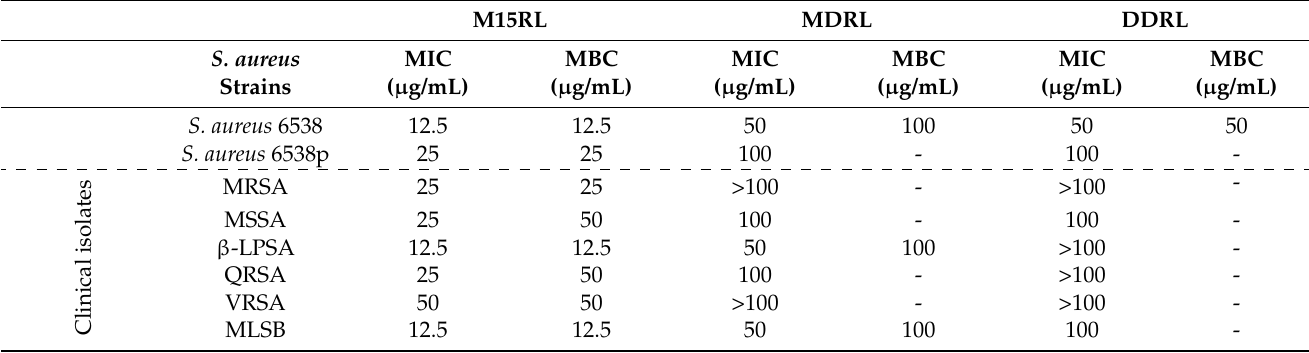
Table 2. Antimicrobial activity of M15RL, MDRL, and DDRL against S. aureus strains. M15RL